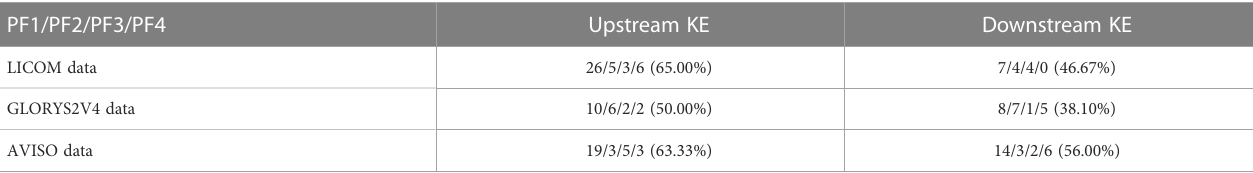
TABLE 2 The number of eddies with the largest value of b in PF1/PF2/PF3/PF4 and the percentages of the number of eddies with the largest value of b in the PF1 to the total eddy number in the upstream and downstream KE regions. PF1/PF2/PF3/PF4